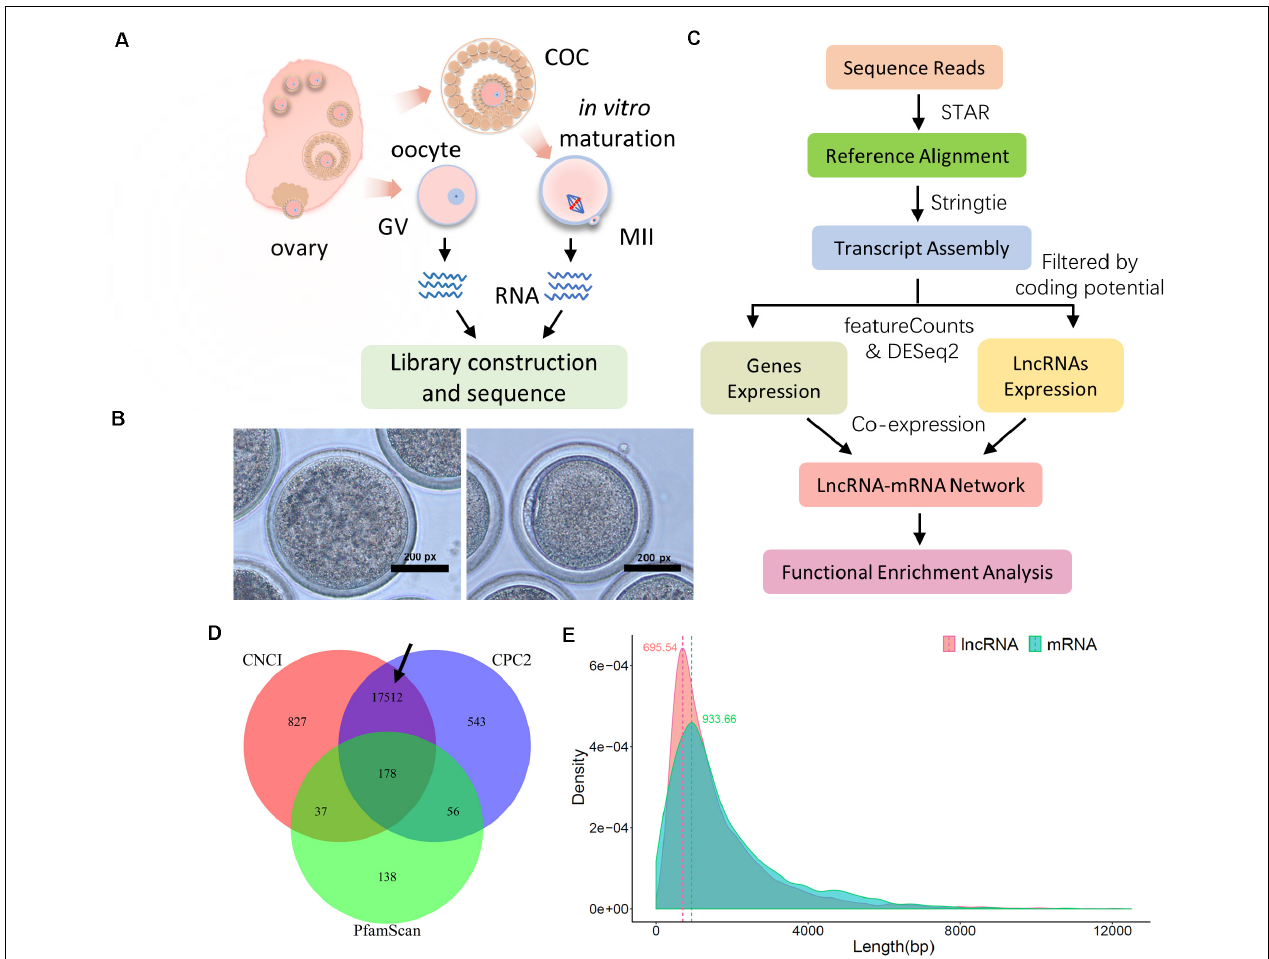
FIGURE 1 | Sequence and data preprocessing of ovine oocytes at the germinal vesicle (GV) and meiosis II (MII) stages. (A) Schematic diagram of sample collection and RNA sequencing procedure. (B) Representative bright-field images of ovine GV (left) and MII (right) oocytes. (C) Data preprocessing pipeline for mRNA and lncRNA. (D) Candidate lncRNA identification with coding potential assessment of CNCI, CPC2, and PfamScan; the black arrow refers to the final candidate lncRNA. (E) Distribution of transcript length of lncRNA and mRNA; the transcript length of lncRNA and mRNA was generated using the assembly process of StringTie software, and density distribution was assembled using the ggplot2 package in the R